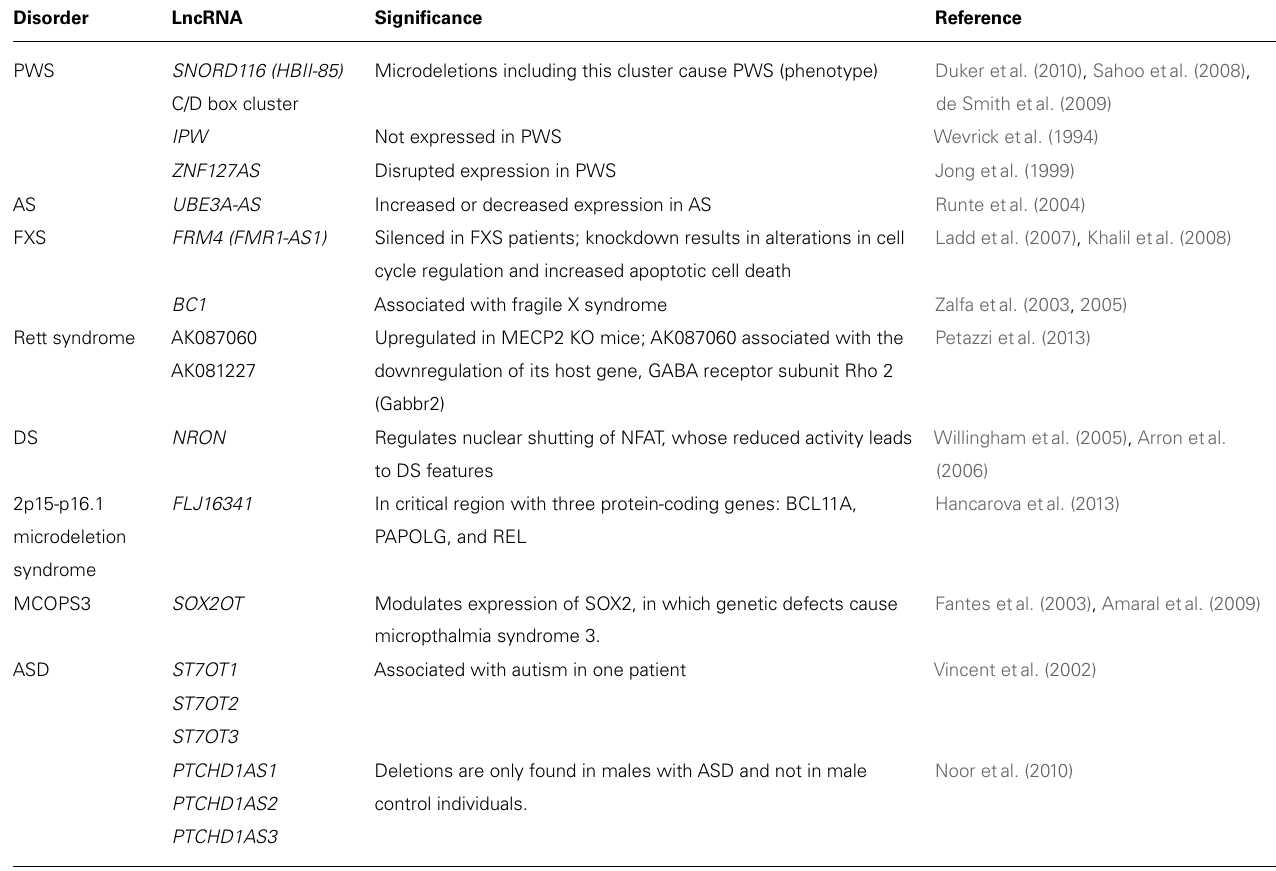
Table 1 |An overview of the lncRNAs identified in neurodevelopmental